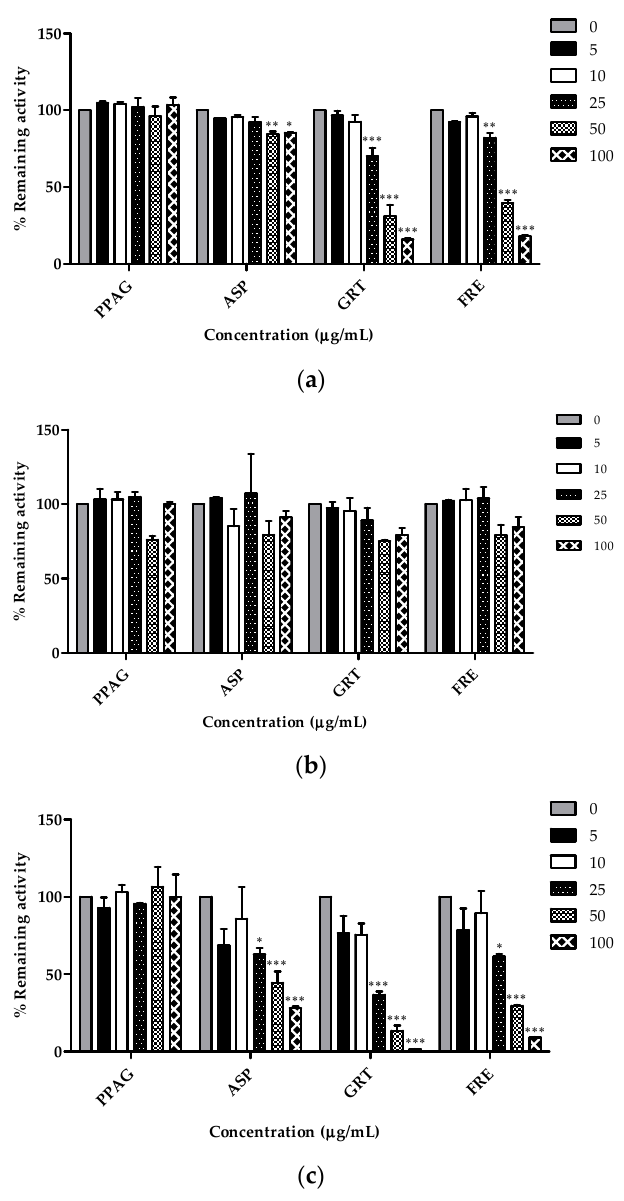
Figure 4. Percentage remaining activity of ( a ) CYP2C8; ( b ) CYP2C9 and ( c ) CYP3A4 following 30 min pre-incubation with PPAG ( Z -2-( β - D -glucopyranosyloxy)-3-phenylpropenoic acid), ASP (aspalathin), GRT (unfermented rooibos extract), and FRE (fermented rooibos extract) at varying concentrations in the presence of NADPH with subsequent addition of substrates. Data are the average values of duplicate experiments with two replicates per sample ( n = 4). * p < 0.05, ** p < 0.01, *** p < 0.001 when compared to other concentrations.